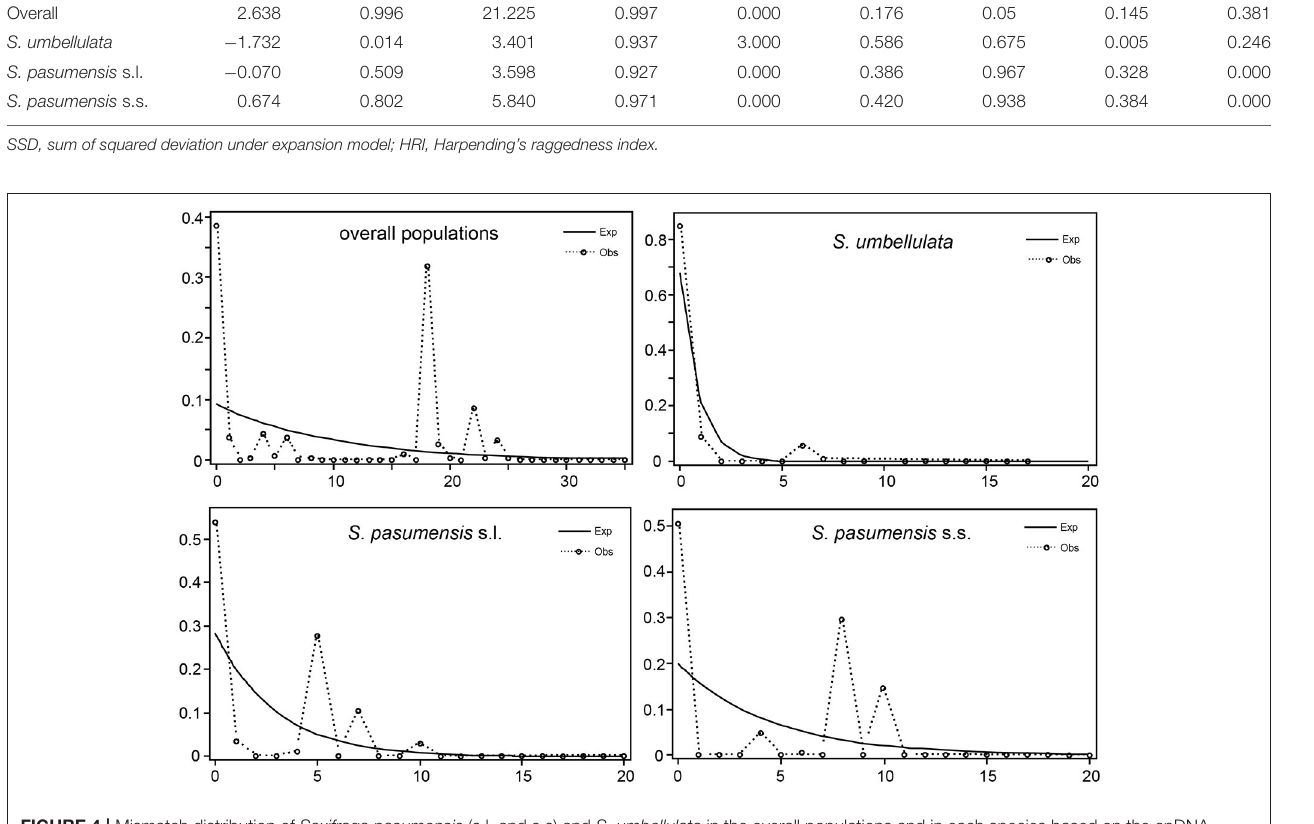
FIGURE 4 | Mismatch distribution of Saxifraga pasumensis (s.l. and s.s) and S. umbellulata in the overall populations and in each species based on the cpDNA